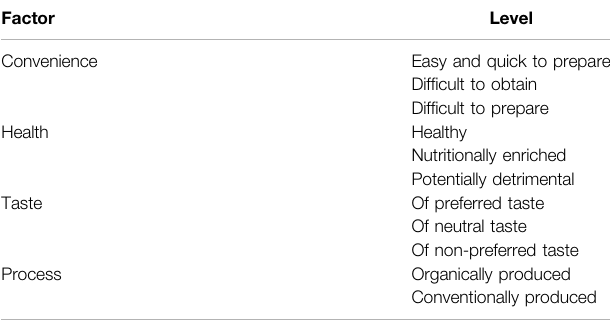
TABLE 1 | Products attributes and their respective level.